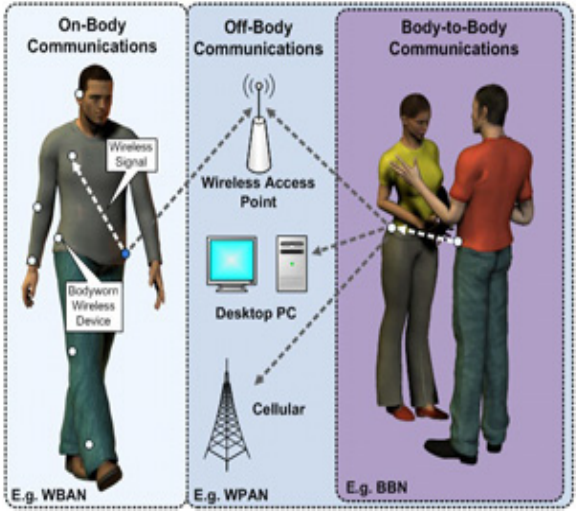
Figure 1. Overview of On-Body, Off-Body and Body-to-Body